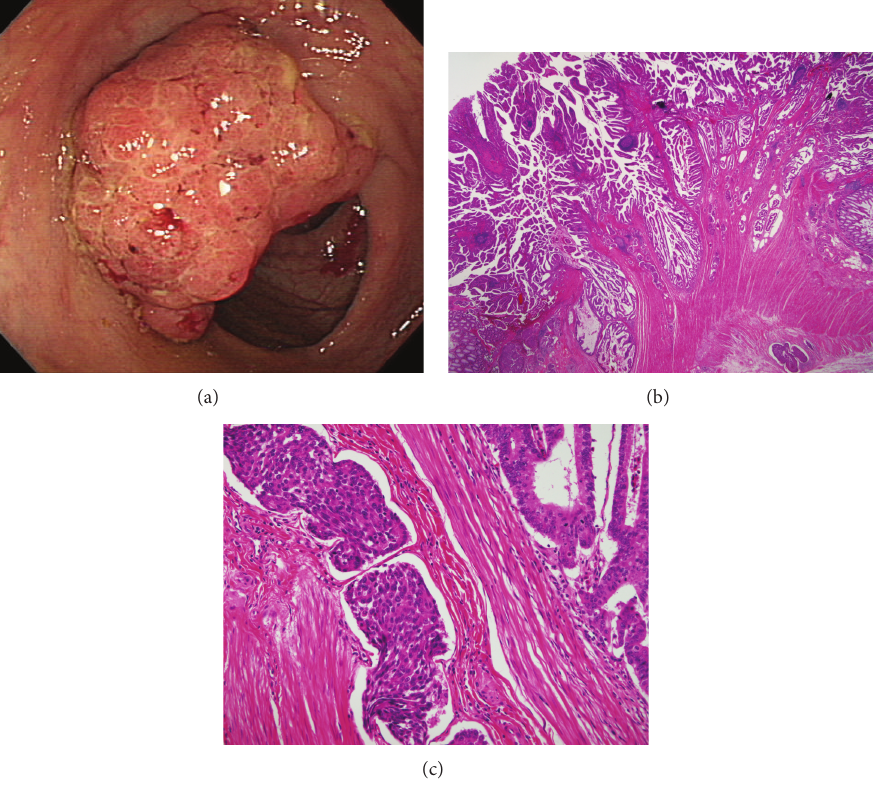
Figure 2: Representative example of serrated adenocarcinoma from patient number 11. Endoscopic findings showing 3.5 × 2.8 cm sized fungating mass in the descending colon (a), histologic findings showing crypts with dilation, serration, and irregular branching, original magnification × 12 (b), and tumor cells showing abundant cytoplasm, absence of necrosis, and eosinophilic cytoplasm, original magnification × 200